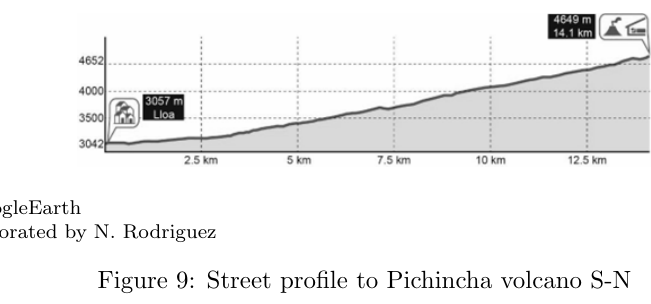
Figure 9: Street profile to Pichincha volcano S-N